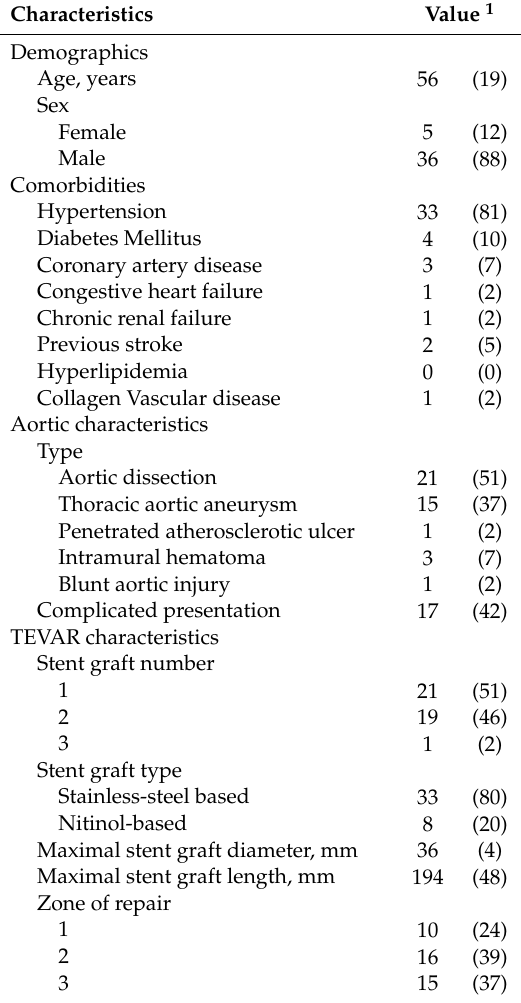
Table 1. Patient characteristics ( n =